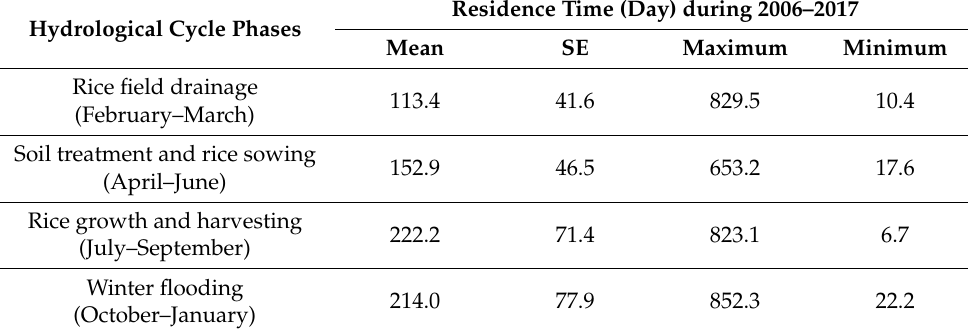
Table 2. Mean, standard error, maximum and minimum values of the residence times of the Albufera Lake for the different hydrological cycle phases established (data from